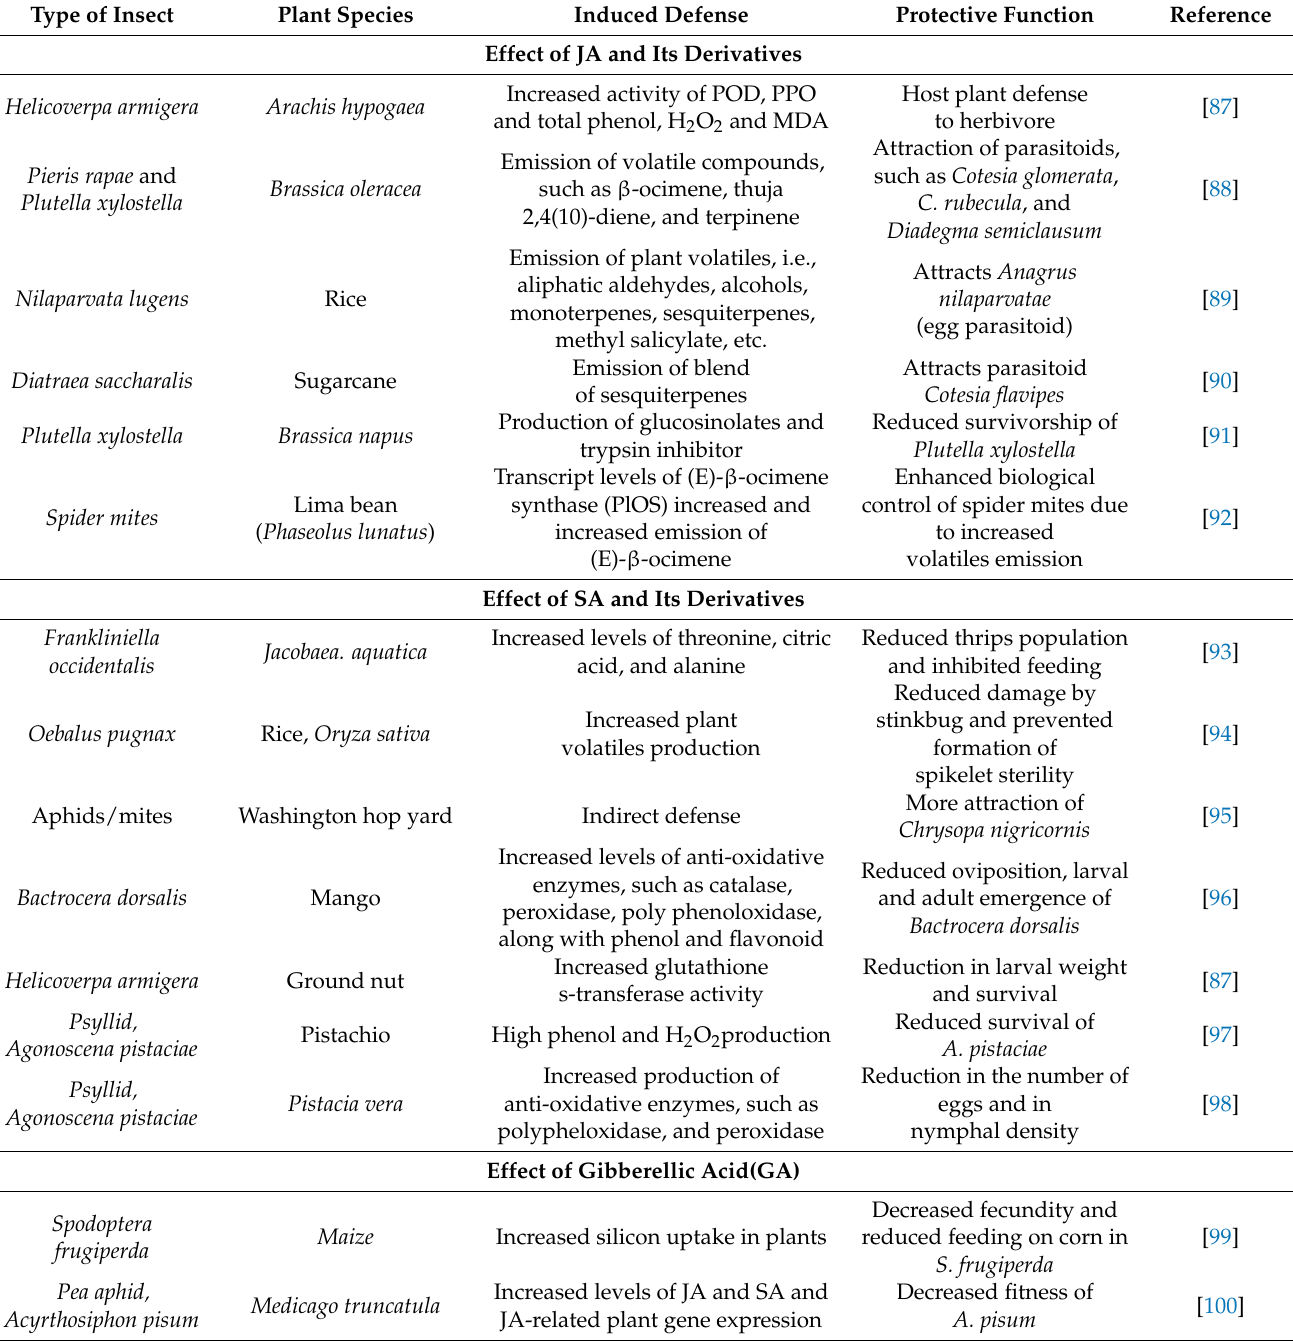
Table 1. External application of phytohormones in inducing plant defense to